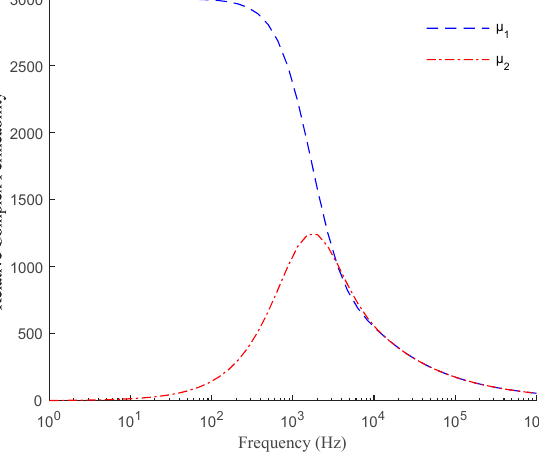
Figure 7. Variation of relative complex permeability with frequency.